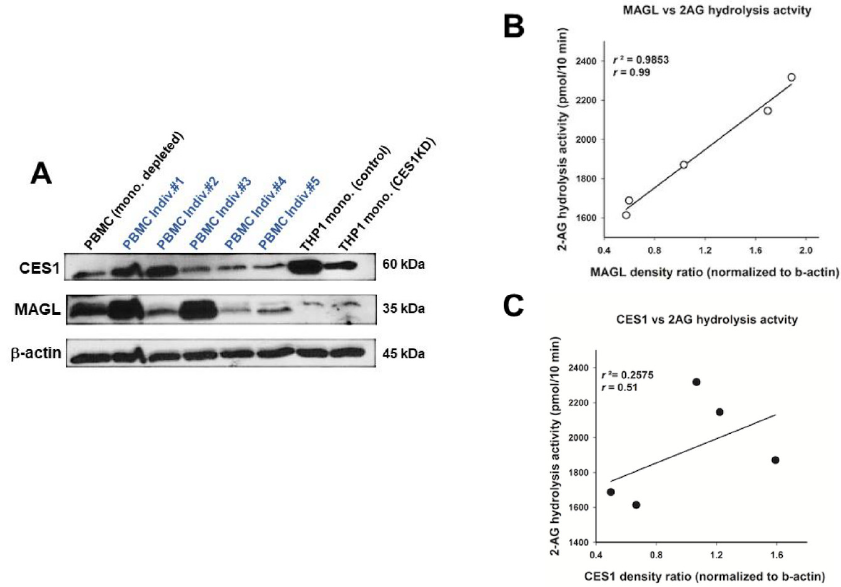
Figure 3. Western blots of CES1 and MAGL in human PBMCs and correlation analysis. ( A ) Commercially obtained PBMC lysates (25 µ g of protein per sample; n = 5 individuals) and a monocyte-depleted PBMC lysate (25 µ g of protein per sample; n = 1 individual) were separated by SDS-PAGE and probed with antibodies against CES1, MAGL, and β -actin. β -Actin was used as a loading control. THP-1 monocytic cell lines with high and low levels of CES1 expression (control and CES1 knockdown (KD), respectively; [5]) were used as positive and negative controls. ( B ) The band density for MAGL in each individual ( n = 5) in the Western blot was correlated with its corresponding 2-AG hydrolytic activity. ( C ) The band density for CES1 in each individual ( n = 5) in the Western blot was correlated with its corresponding 2-AG hydrolytic activity (25 µ g protein per sample for Western and 2-AG hydrolytic activity). Spearman regression correlations were determined for both enzymes. p = 0.001 for MAGL; p > 0.05 for CES1.